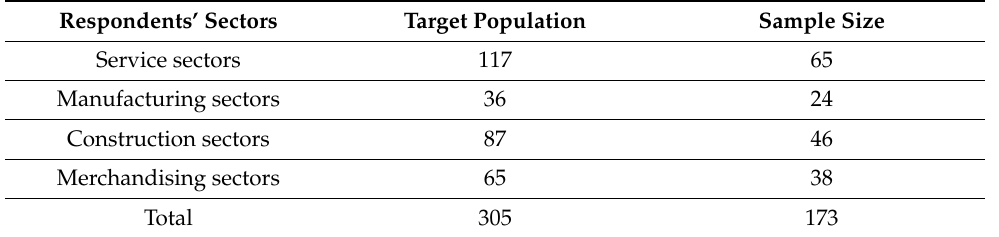
Table 2. Study population and sample. Respondents’ Sectors Target Population Sample Size Service sectors 117 65 Manufacturing sectors 36 24 Construction sectors 87 46 Merchandising sectors 65 38 Total 305